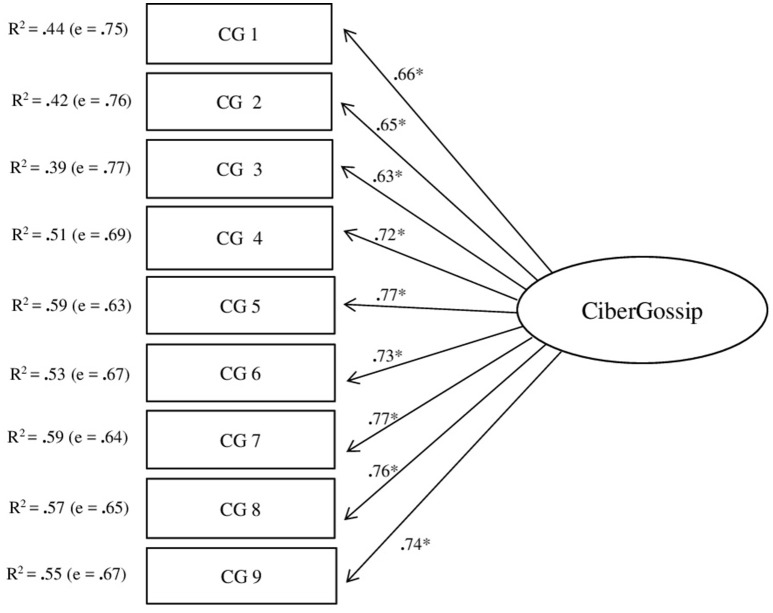
CFA of the CGQ-A scale (*p < 0.05).